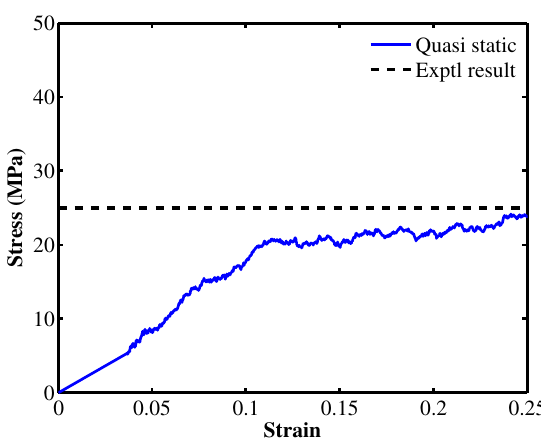
Figure 5. System of PE consisting of 40 PE molecules. Table 1. Mechanical properties of the PE (units in GPa, K and g/cm 3 ).